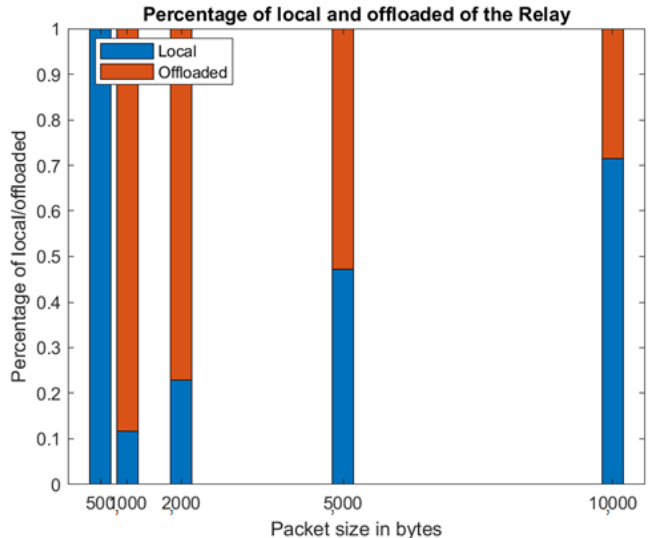
Figure 15. Percentage of locally computed and offloaded packets of the relay node.